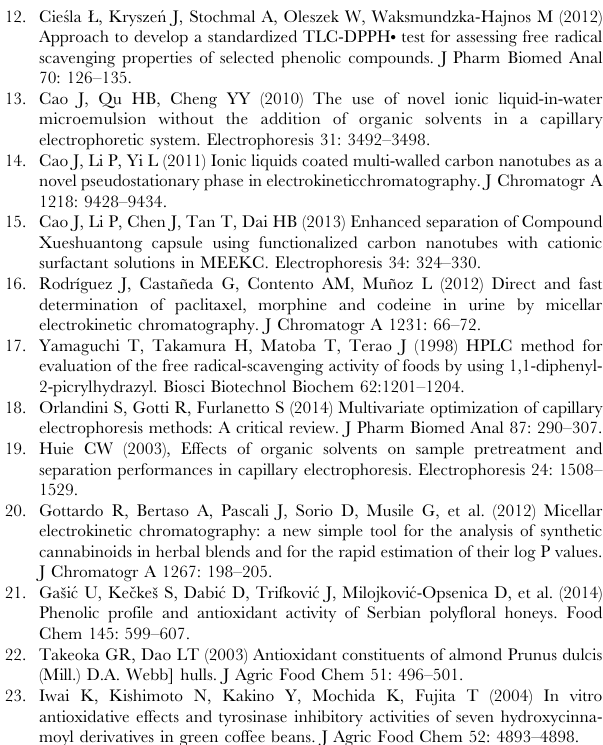
Figure S3 Some electrophoretograms of standard mix- ture of seven compounds with poor resolution in different experimental conditions : (A) pH = 4.4, 20